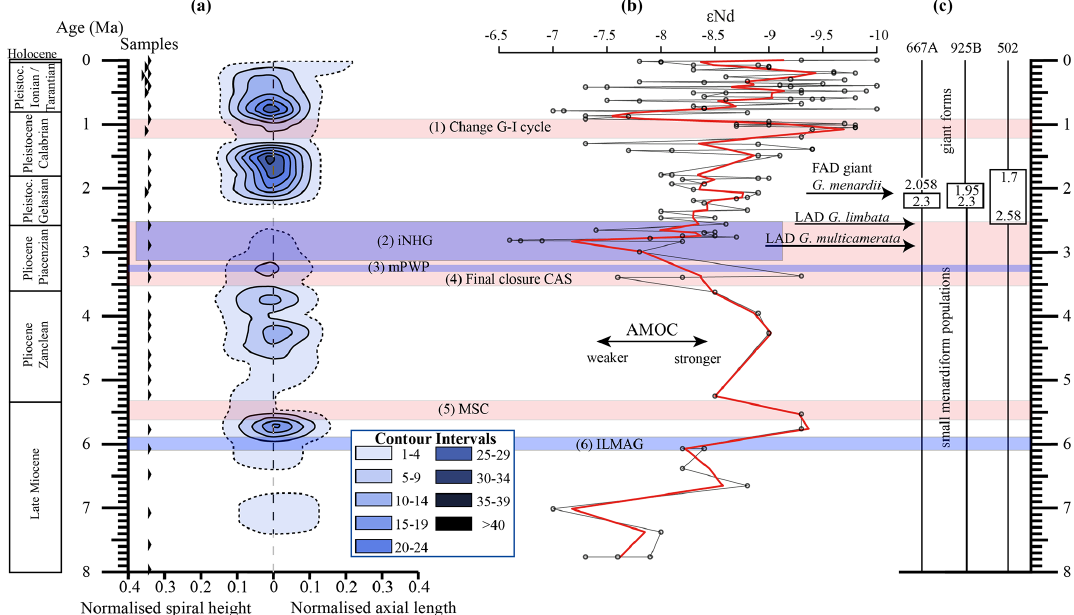
Figure A6. Sagittal section with an offset value of − 0.23 through the 135 ◦ view on the VDD of Hole 667A in a palaeoceanographic context. The dotted line represents the interval line 1, and the solid lines show the contours with an interval of 5. The vertical dashed line at x = 0 symbolises the position of the z axis, which is hidden behind the contour plot. The position of this section within the VDD is plotted in Fig. A2. For further explanation, see Fig. 10 in the text.